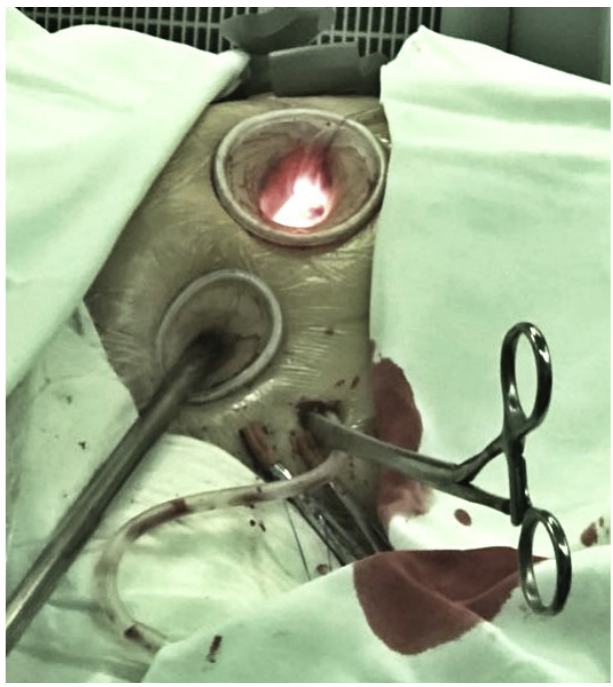
Fig. 1 - Position of the main and thoracoscopic